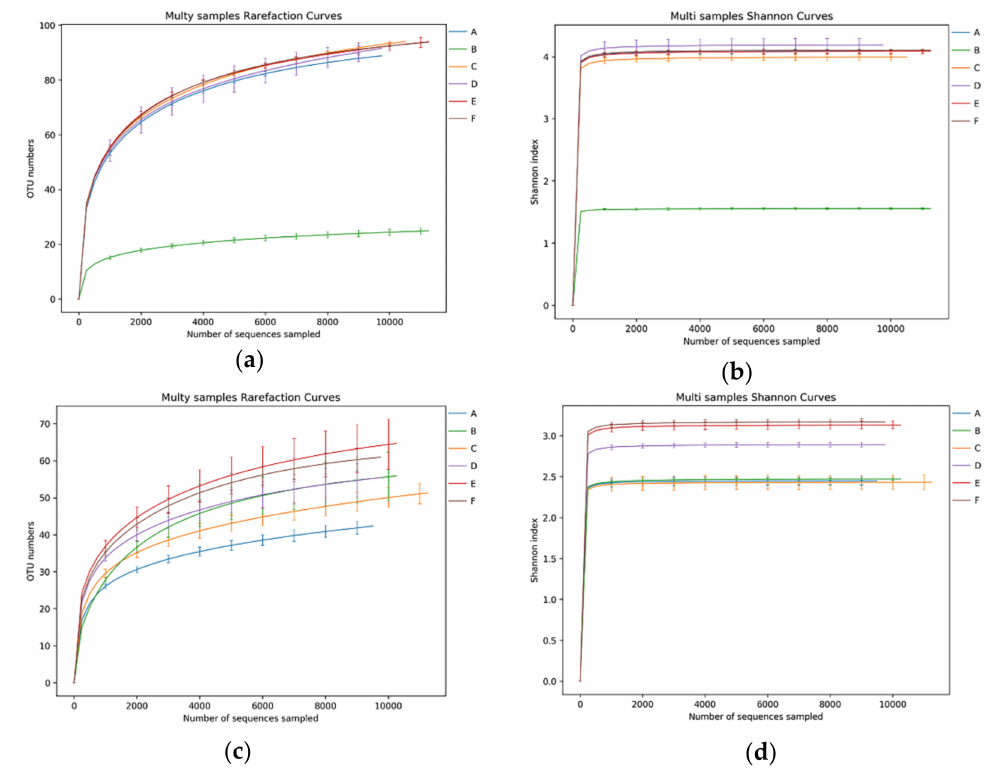
Figure 2. Rarefaction curve and Shannon curve of sequencing reads of ( a , b ) the bacterial 16S rDNA gene and ( c , d ) the fungal ITS rDNA gene from CTN